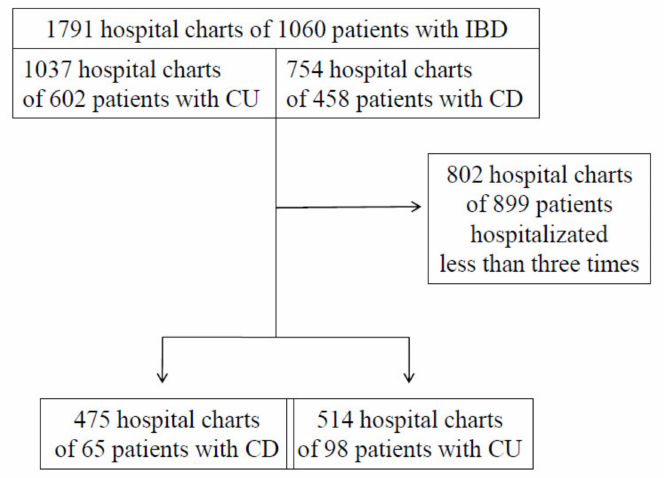
Figure 1. Flowchart for patient